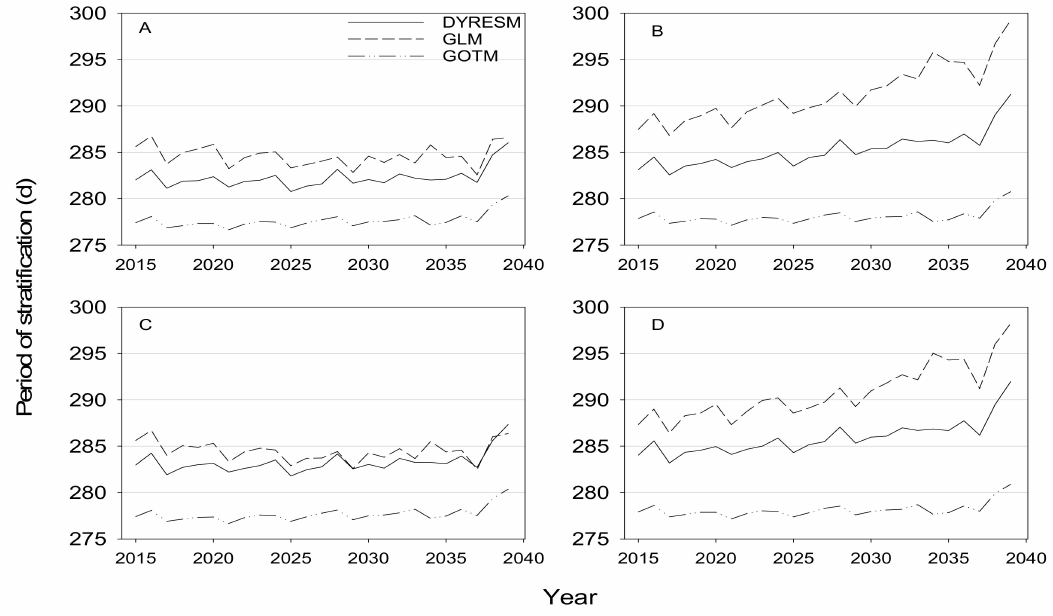
Figure 11. Mean stratification period based on the results of the ensemble of models for the Unchanged ( A ), LI ( B ), HW ( C ) and HW-LI ( D )